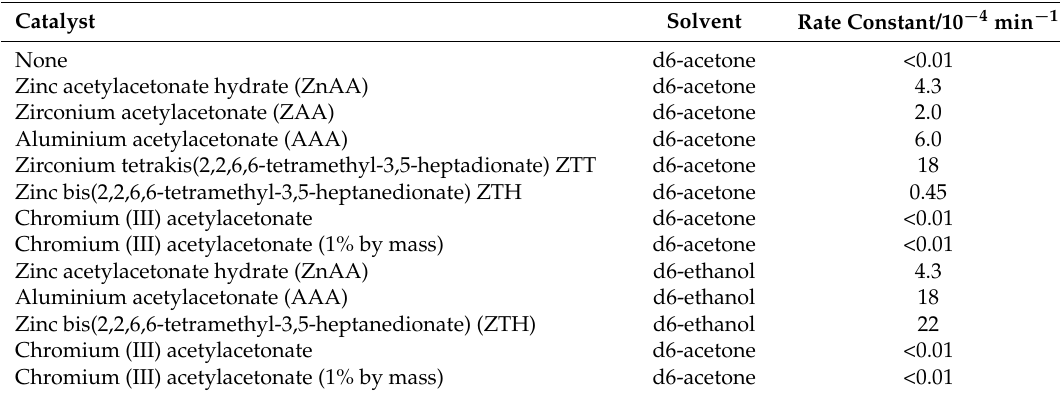
Table 2. Hydrolysis rates of GPS with different catalysts. Reprinted with permission from [26]. Copyright Elsevier, 2006.